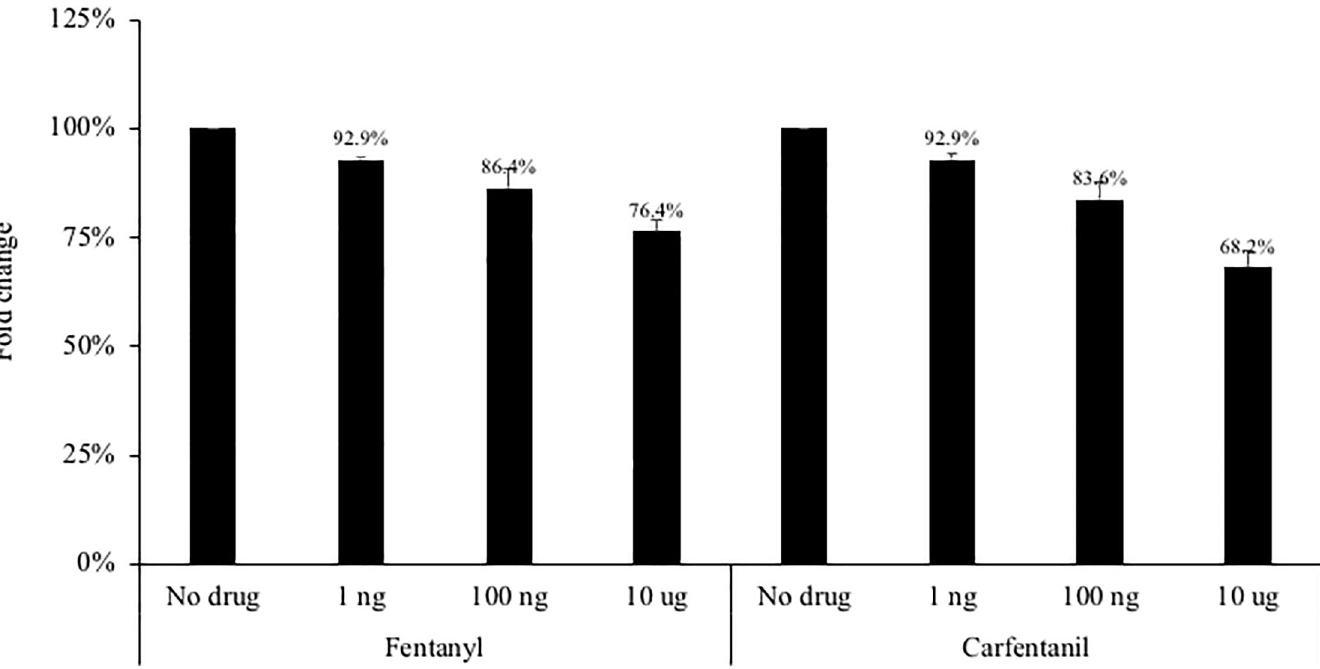
Fig 7. The Huh7.5 JFH1 hepatocyte cell line was seeded at 500,000 cells per well. Fentanyl or carfentanil was added to culture medium after 24 hours. After 24 hours of incubation with drug, the potential toxicity was evaluated by the MTT Cell Proliferation Assay Kit. ANOVA for dose effect: p = 0.044 for fentanyl and p = 0.028 for carfentanil.